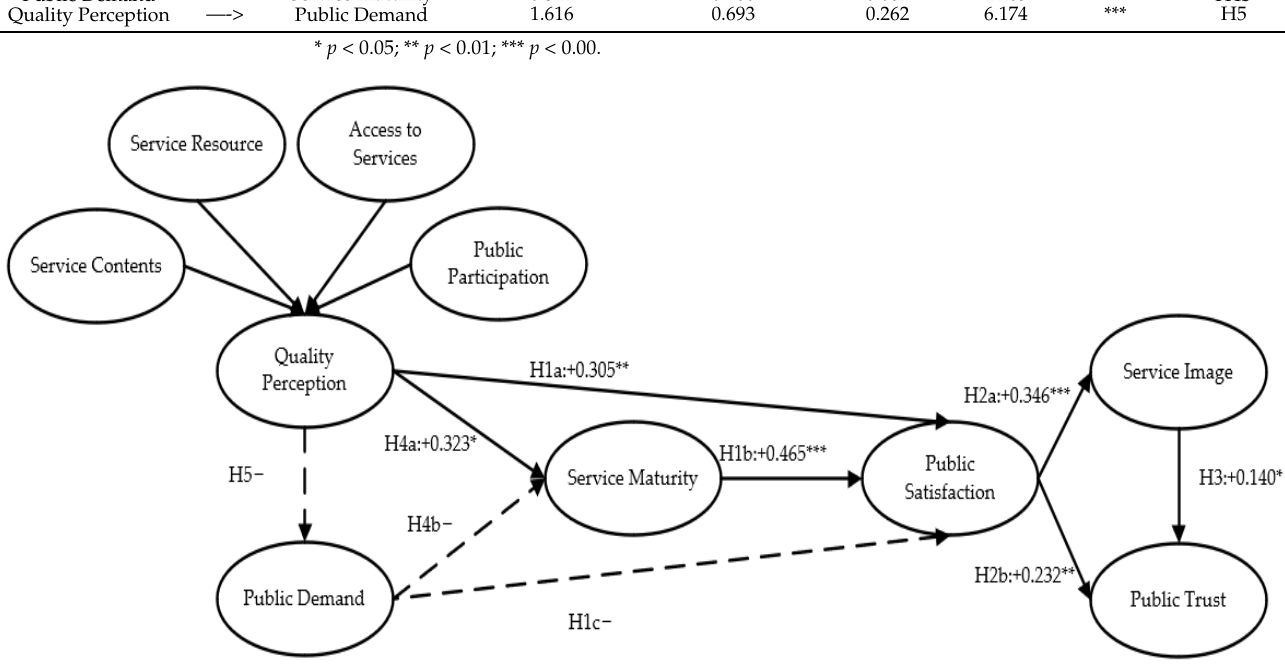
Figure 4. The results of the public satisfaction model. * p < 0.05; ** p < 0.01; *** p < 0.00.